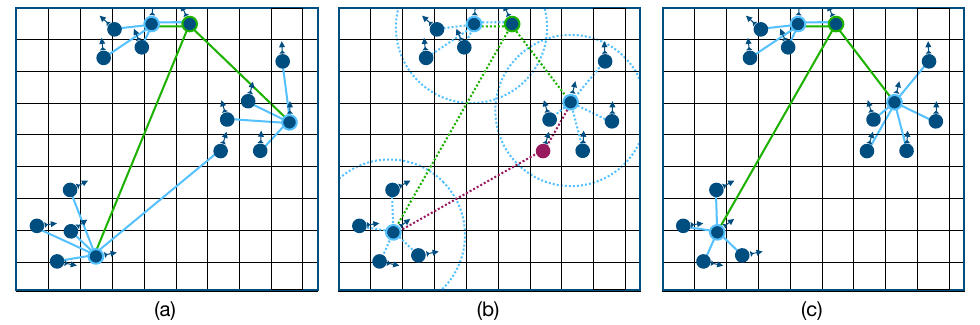
Figure 7. Member transfer and cluster-head reassignment. ( a ) A cluster-member drifts away from its Figure 10: An event sequence before, during, and after the cluster maintenance phase. (a) Before cluster maintenance, an agent drifts away from its cluster-head. (b) During cluster-maintenance, the cluster-head. ( b ) The cluster elects a new cluster-head closer to the centroid. ( c ) The new cluster-head agent closest to the centroid of the cluster is elected cluster-head. Each agent determines whether it initiates a transfer which allows the remote member to join the more suitable lies within a predefined distance of its cluster-head. The metric for distance may involve some weighted combination of position and velocity. Agents outside this radius look for external cluster- heads that may be in range. (c) After cluster maintenance, agents belong to newly reconstituted stable clusters.